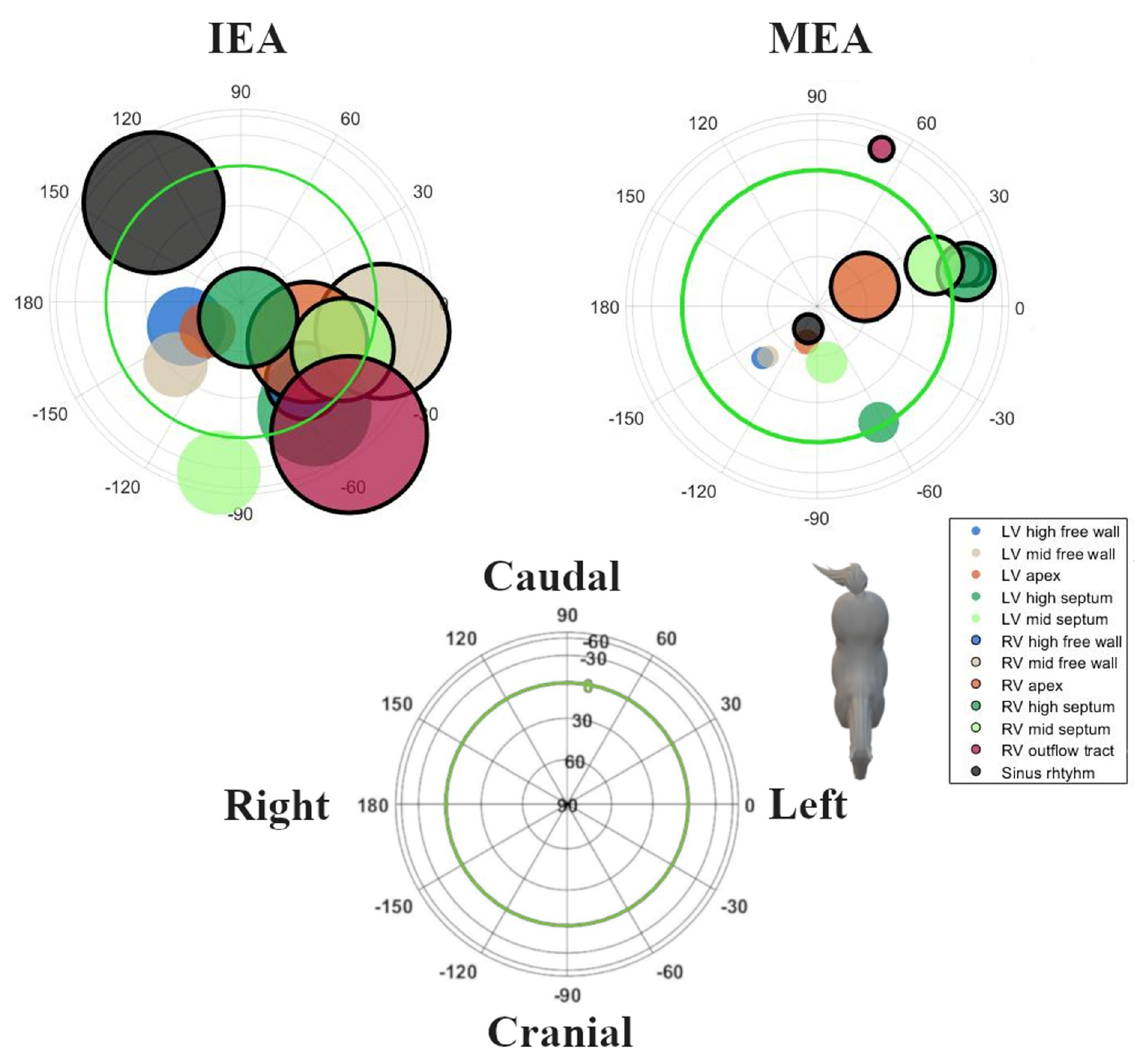
Figure 5. Maximum spatial direction and concentration parameter κ of both the initial (IEA) and maximum (MEA) electrical axes of the QRS complex for induced VPDs and SR, visualized with a Lambert azimuthal equal-area plot. The IEA was defined as the first deflection from the onset of the QRS complex, while the MEA was the largest deflection of the QRS complex. Circles inside the green circle represent a dorsal MEA, while outside circles represent a ventral MEA. Left is 0°, caudal is 90° azimuth and dorsal is 90° elevation. A larger circle indicates a lower κ value and thus a higher spreading of the individual points.